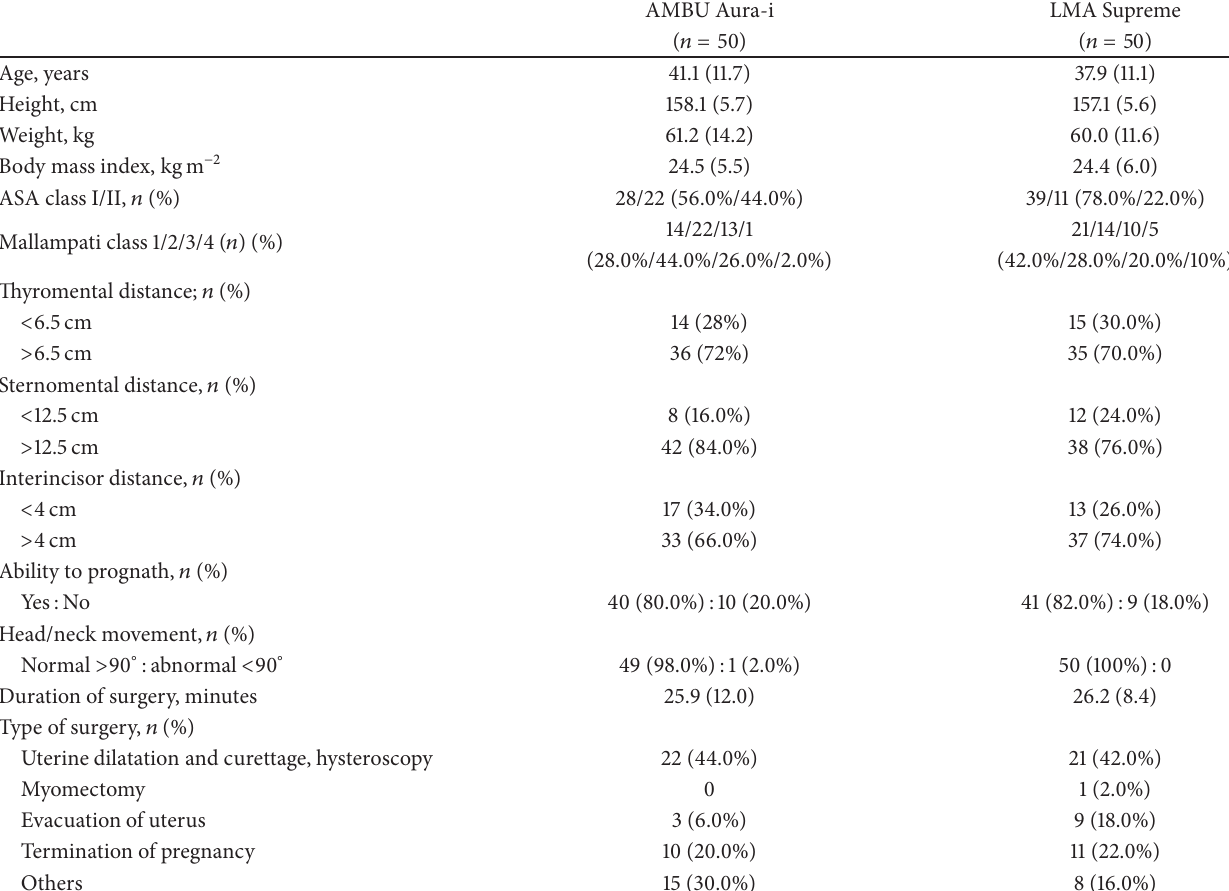
Table 1: Patient characteristics. Data are expressed as mean (SD) or numbers of patients ( 𝑛 ) and percentages